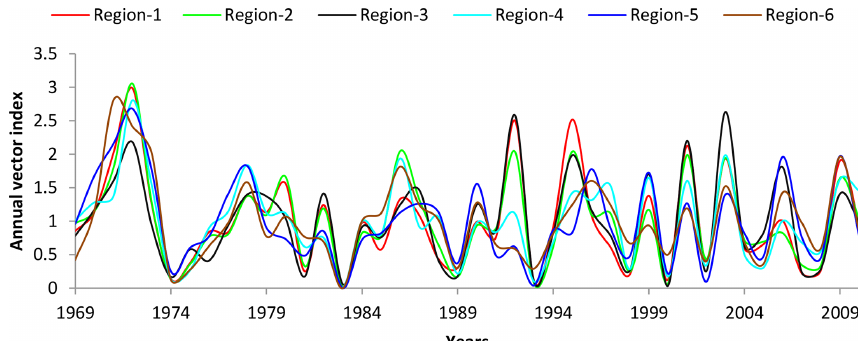
Figure 1. Study area and delineation of homogeneous regions.